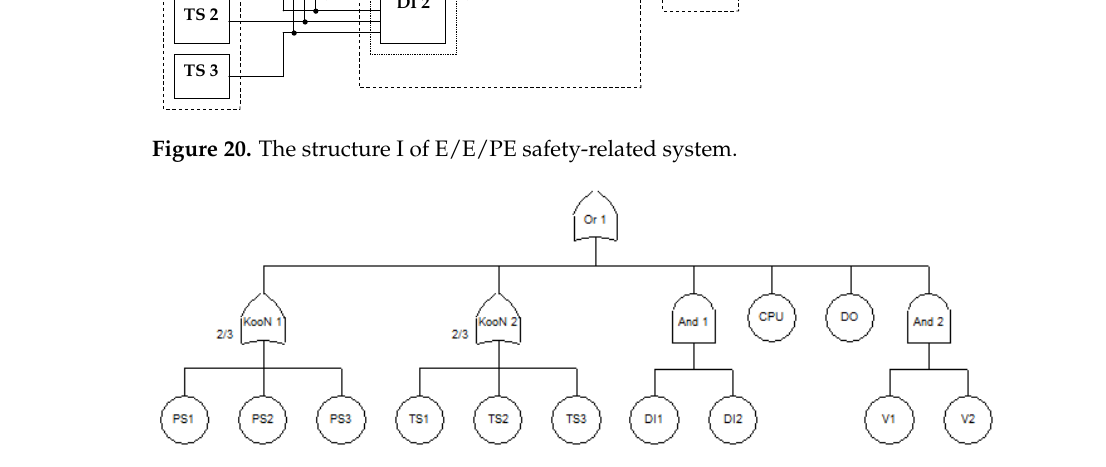
Figure 21. FT structure I model of E/E/PE safety-related system.